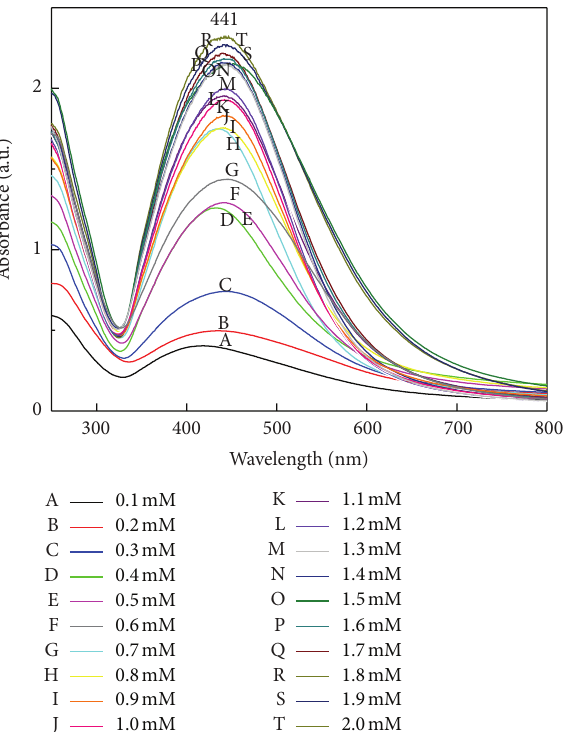
Figure 10: Effect of filtrate volume on synthesis of SNPs (1mM AgNO 3 ). 100% reduction of silver ions takes place in 100mL of filtrate.